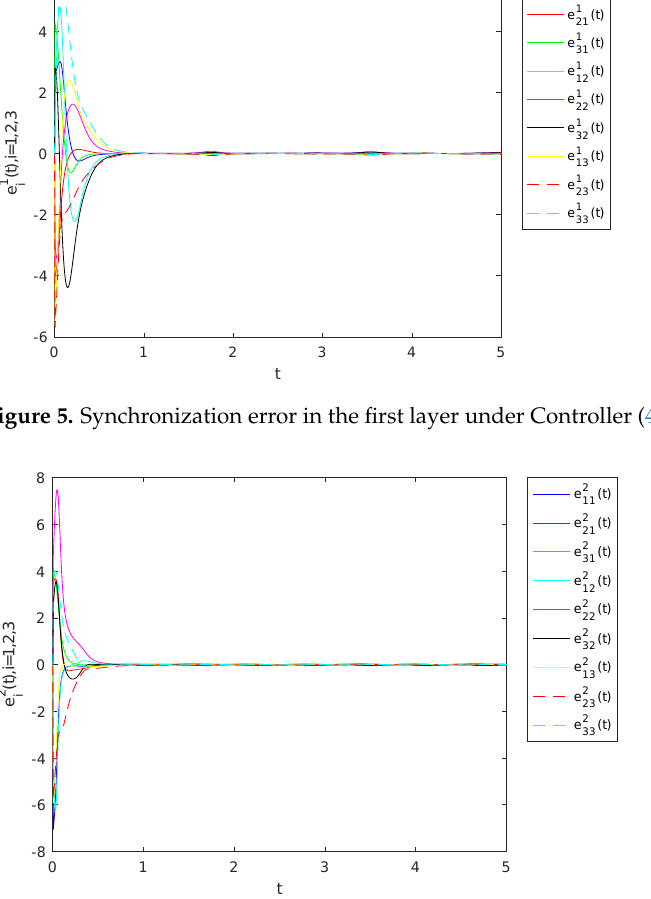
Figure 6. Synchronization error in the second layer under Controller (4).